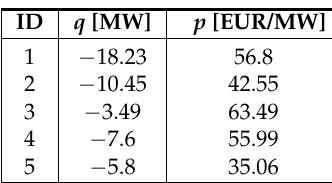
Table A7. Reference (non-SRDB) RD- bid set: The columns correspond to the index of the bid (ID), quantity ( q ) and bid price ( p ) respectively. The SRDB bids are generated according to u , and the implied actual set of uncertain energy